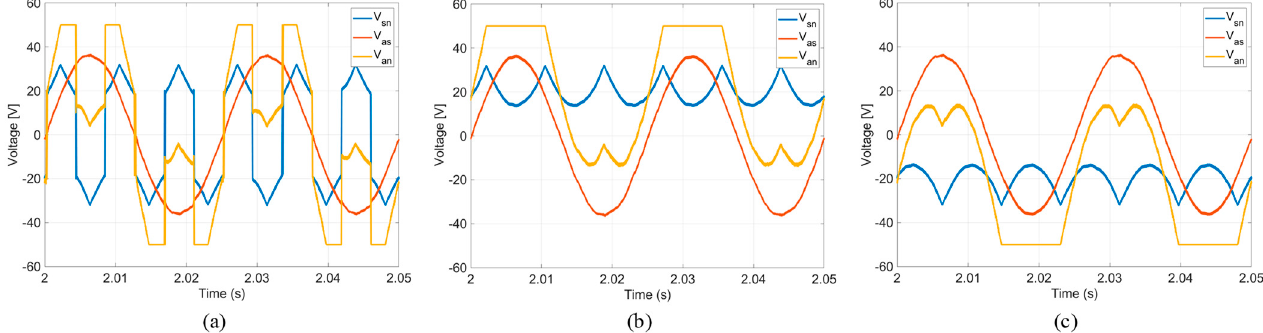
Figure 10. Voltage relations of other DPWM s : ( a ) + 30 ° DPWM; ( b ) 120° (on) DPWM; ( c ) 120° (off) DPWM.